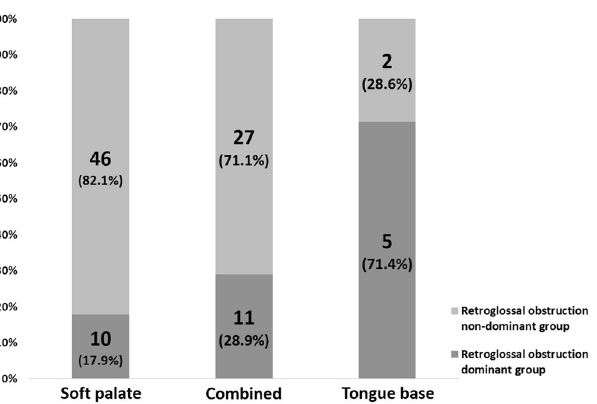
Figure 2. Proportion of retroglossal obstruction dominant and non-dominant groups according to the obstruction pattern evaluated by